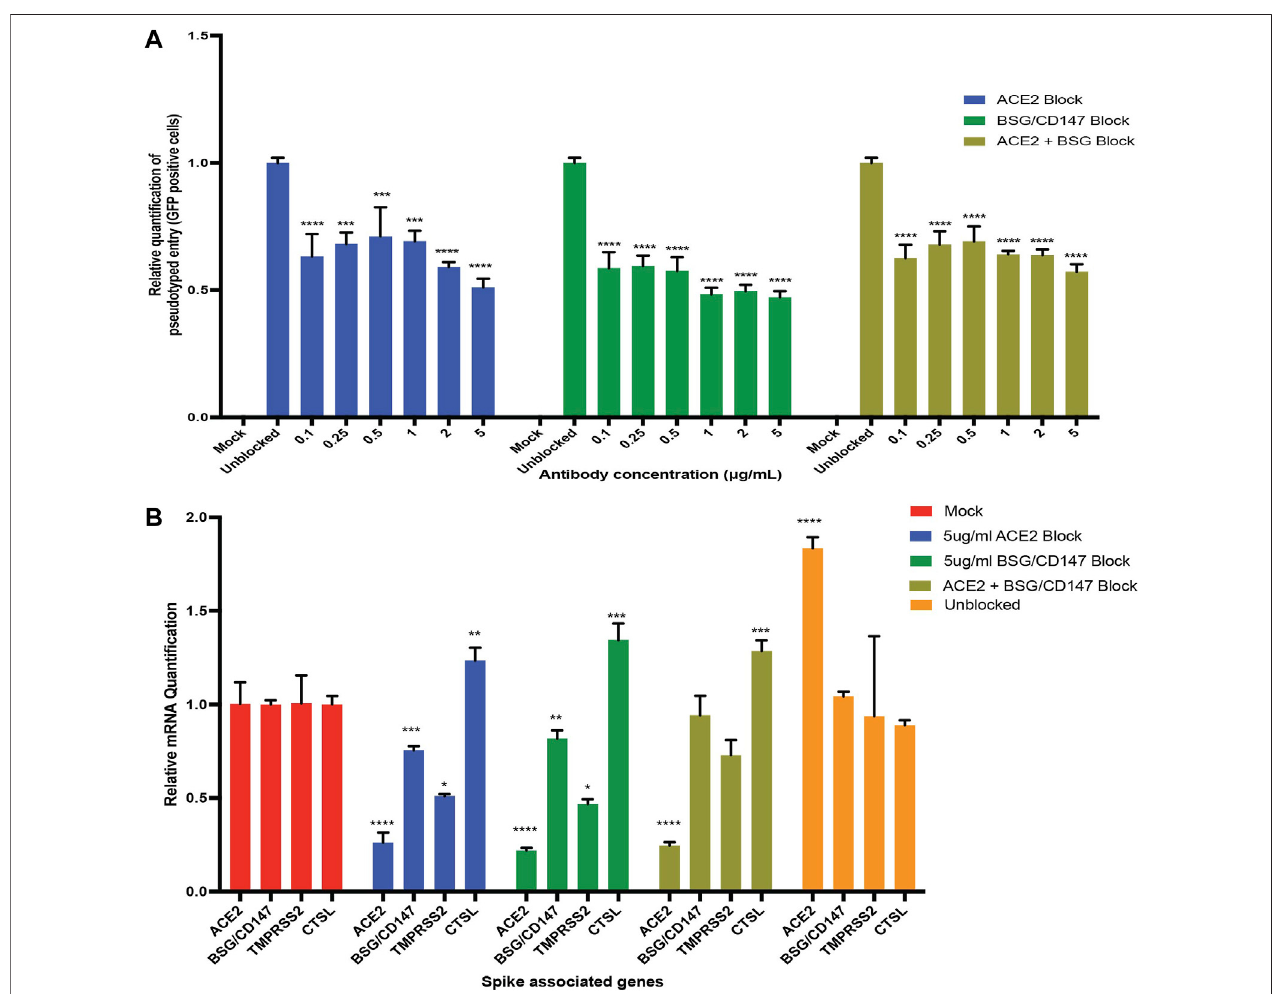
FIGURE5| AntibodyblockingrevealrolesofACE2and BSG/CD147 receptorsinviraluptake. (A) qPCRquanti fi cation ofS-pseudotypedentryrelative toantibody concentration (normalized to unblocked samples). Human iPS cell-derived podocytes were incubated with different dilutions of anti-ACE2, anti-BSG or both for an hour followedbyinfectionwithS-pseudotypedvirusatMOI0.02for60 h (B) qPCRquanti fi cationofSpikebindingreceptorgenes(ACE2,BSG/CD147)andSpikeprocessing factorgenes(TMPRSS2,CTSL)at5 µg/mlforbothanti-ACE2antibodyblockageandanti-BSGantibodyblockageshowingsigni fi cantchangesingeneexpression with optimal receptor blockage when compared to unblocked samples (normalized to mock groups). One-way analysis of variance (ANOVA) with Sidak ’ s multiple comparison test was used to determine statistical signi fi cance. Only p values of 0.05 or lower were considered statistically signi fi cant ( p > 0.05 [ns, not signi fi cant], p < 0.05 [*], p < 0.01 [**], p < 0.001 [***], p < 0.0001 [****]). Error bars indicate standard deviation of the